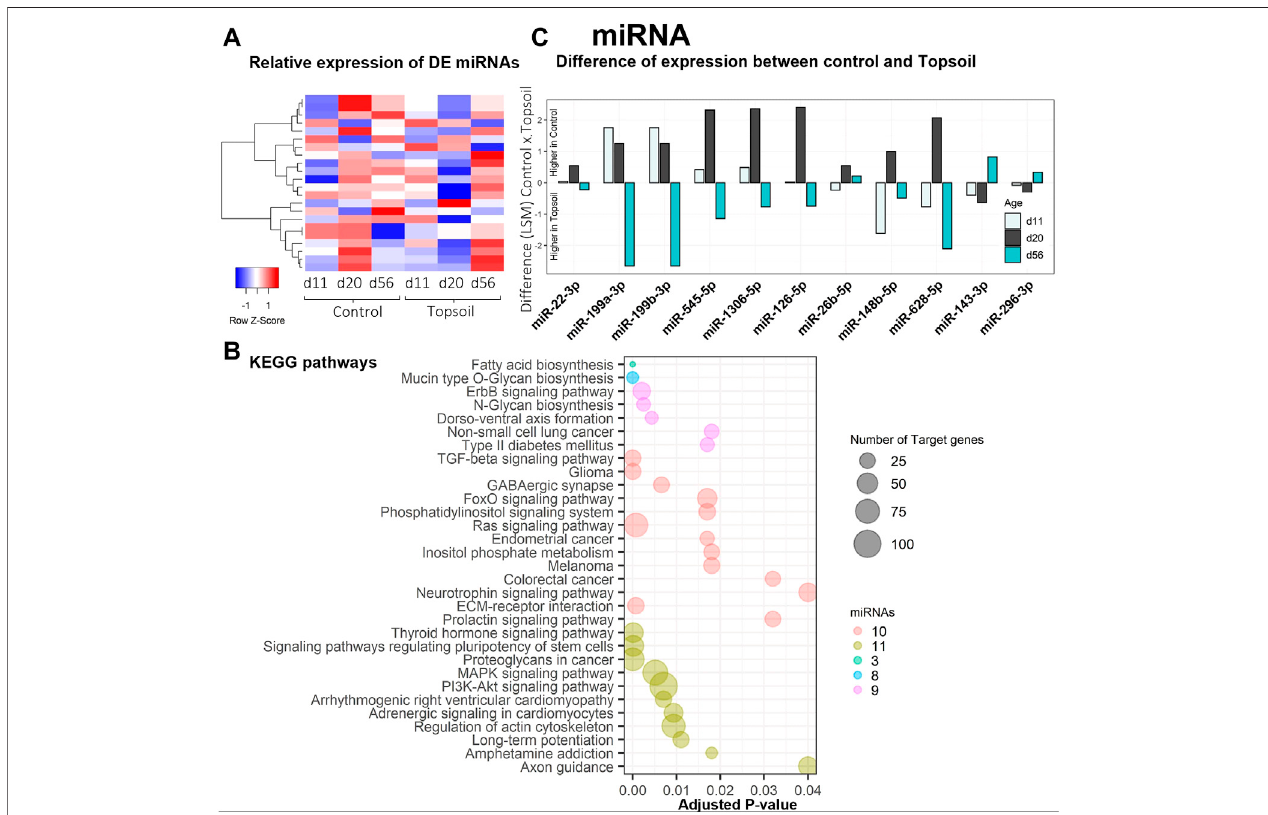
FIGURE 2 | Gene expression and gene ontology (GO) enrichment analysis of the differentially expressed (DE) miRNA response to topsoil treatment (A) A heatmap comparison of the expression of the most highly DE miRNAs across time and treatment (control vs . topsoil) in peripheral blood mononuclear cells (PBMCs.) The three timepointscorrespondtowhenpigswerestillexposedtotopsoilinthenursery(d11)andatweaning(d20)aswellasaftertopsoilwasremovedatthepostweaning(d56) timepoint. The heat map shows the clustered relative miRNA expression (least squares mean — LSM) for control and topsoil treatments by age (day of life/age of piglet:11,20,and56) (B) Visualizationofthenumberandsigni fi canceofKEGGpathway termsidenti fi edbyDIANApathwayontologyenrichment analysisofDEmiRNA. The size of the bubbles represents the number of target genes clustered in the KEGG ontology term group. Bubbles were colored by the number of miRNAs enriched within an ontology group (C) A histogram showing the difference in abundance of miRNA expression between control and topsoil treatment at each time points of miRNAs clustered in the KEGG ontology. Differences in miRNA abundance were estimated using the LSM between control and topsoil treatments at each speci fi c time point (piglet age). Positive differences (above zero) mean higher abundance in the control group while negative differences (below zero) mean higher in topsoil group.